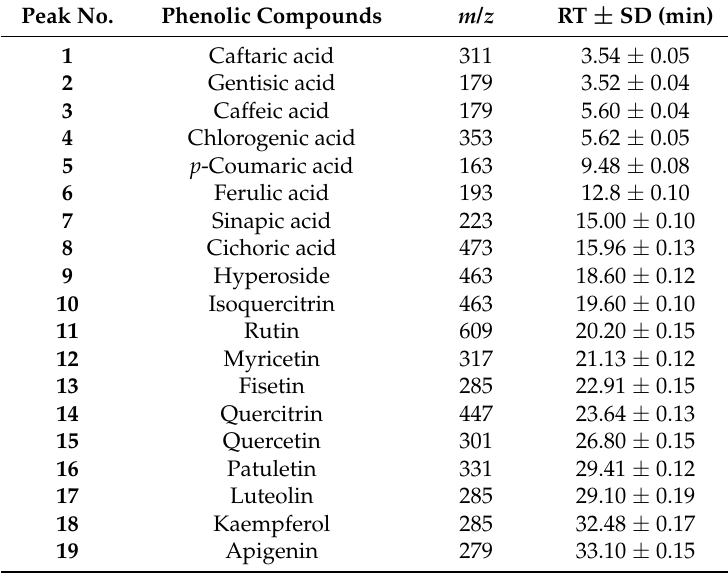
Note: Values represent the mean ± SD (standard deviation).